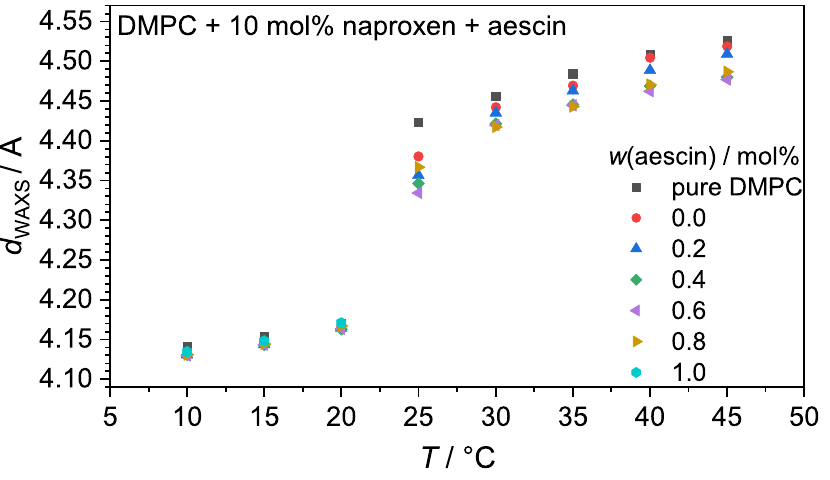
Figure 4. Temperature-dependent d WAXS values of the DMPC vesicles with naproxen and aescin, calculated from the peak maximum q peak via Equation